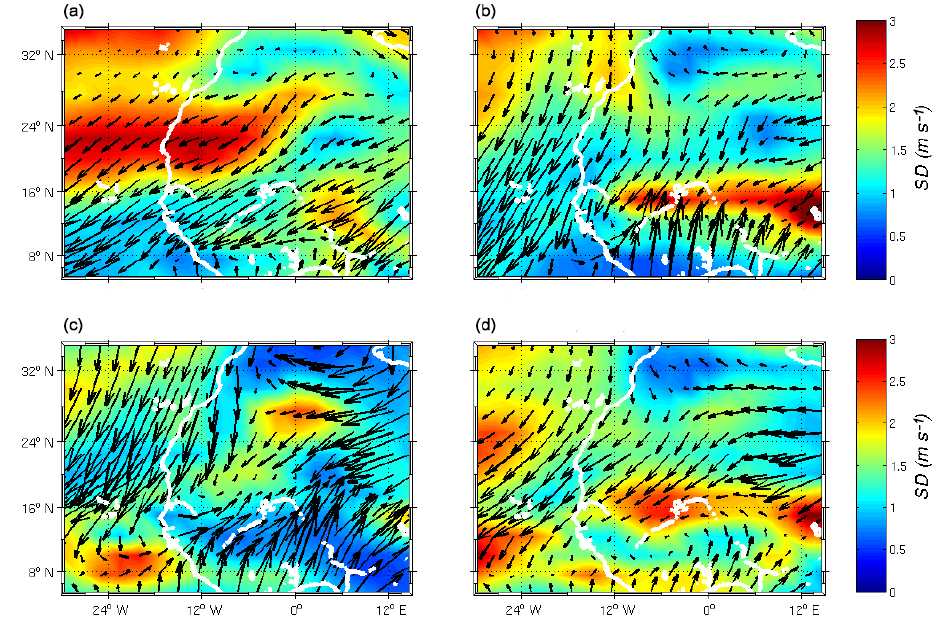
Figure 6. Seasonal mean zonal wind field at 925hPa over western Africa from NCEP Reanalysis between 2000 and 2012: (a) DJF; (b) MAM; (c) JJA; and (d) SON. The vectors show wind direction while colors indicate the standard deviation of wind velocity (ms − 1